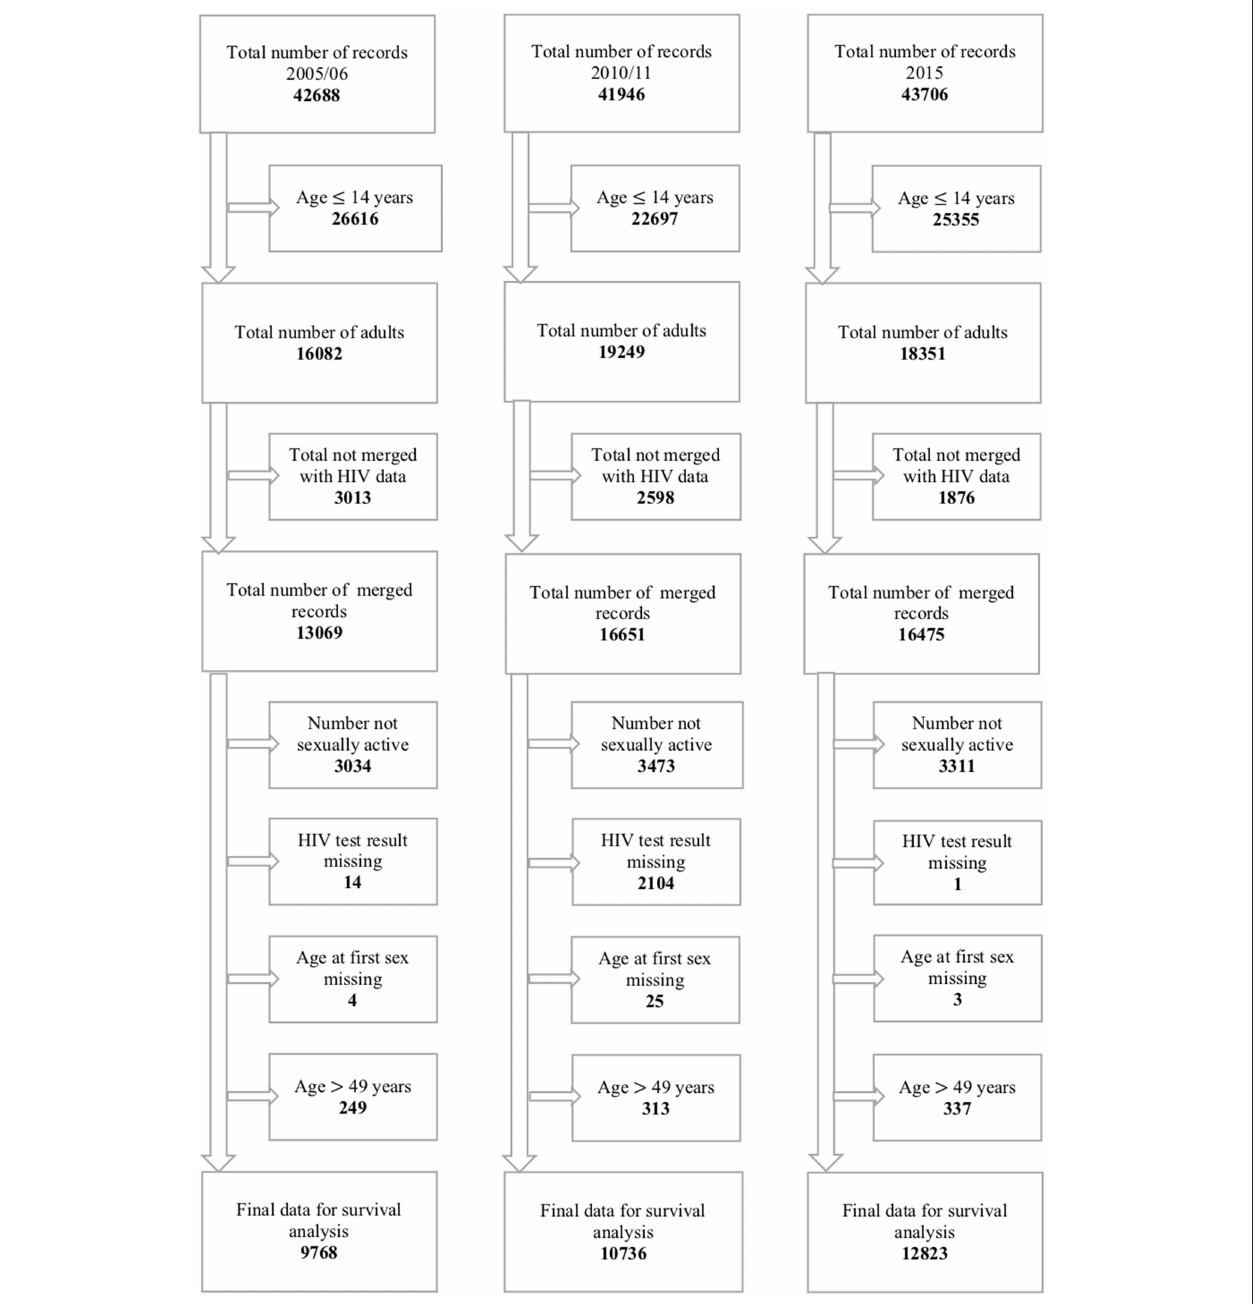
FIGURE 2 | Flowchart of records in the 2005–06, 2010–11, and 2015 ZDHS.